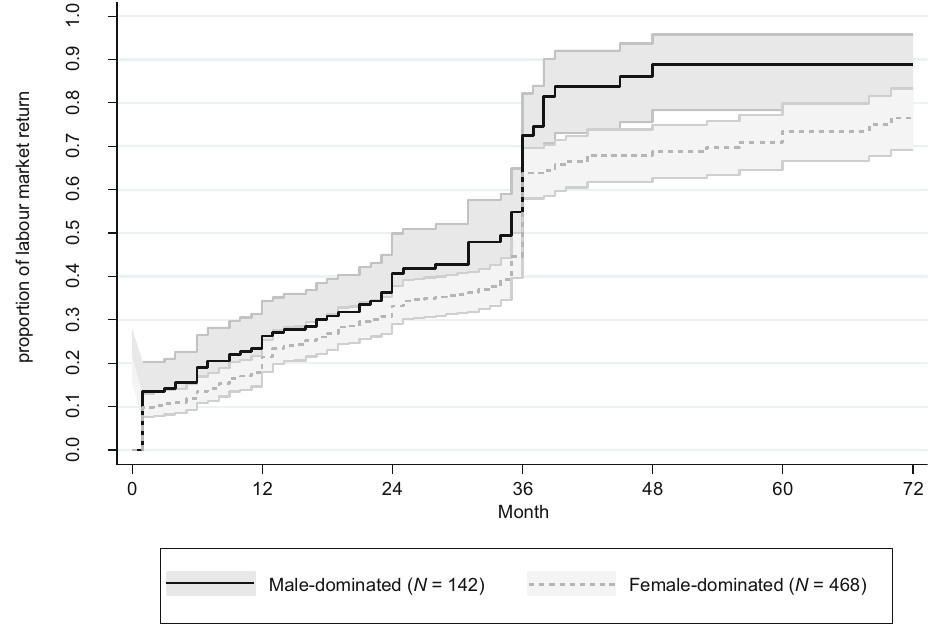
Fig. 2 Kaplan-Meier failure estimate for returning to the labour market after the first child is born. Representation of male-dominated and female- dominated occupations (includ- ing 95% confidence